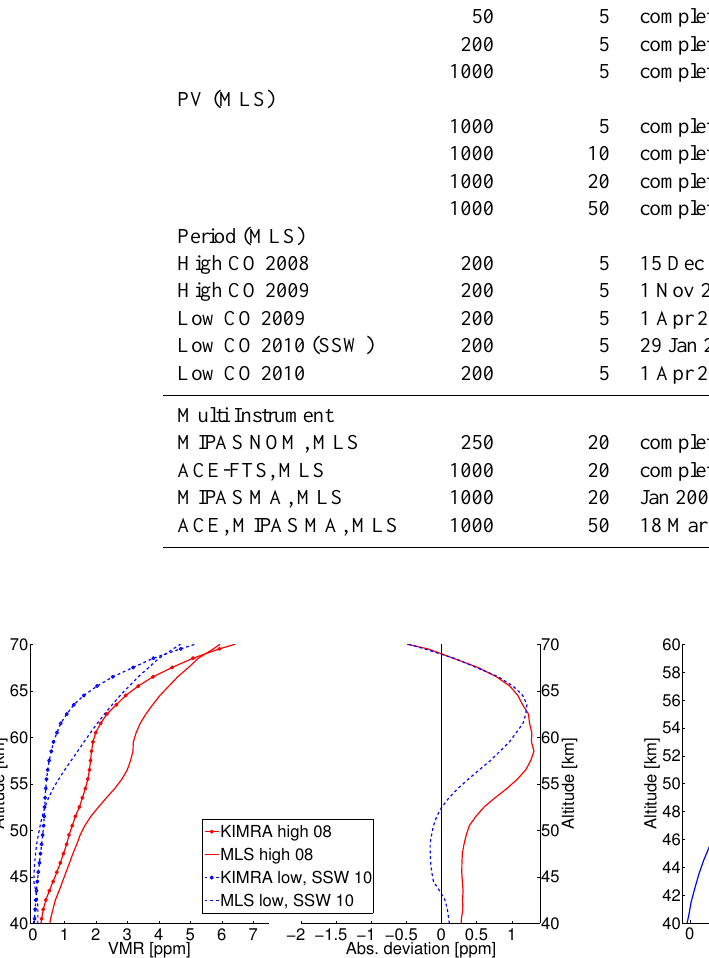
Fig. 14. Comparison of KIMRA with MIPAS (NOM mode) and MLS using the collocation criteria R =250km and 1 PV=20%. 42 days with coincidences were found. Left panel: mean profiles derived according to Sect. 5.1. Right panel: deviation between the KIMRA and the satellite profiles calculated with Eq.